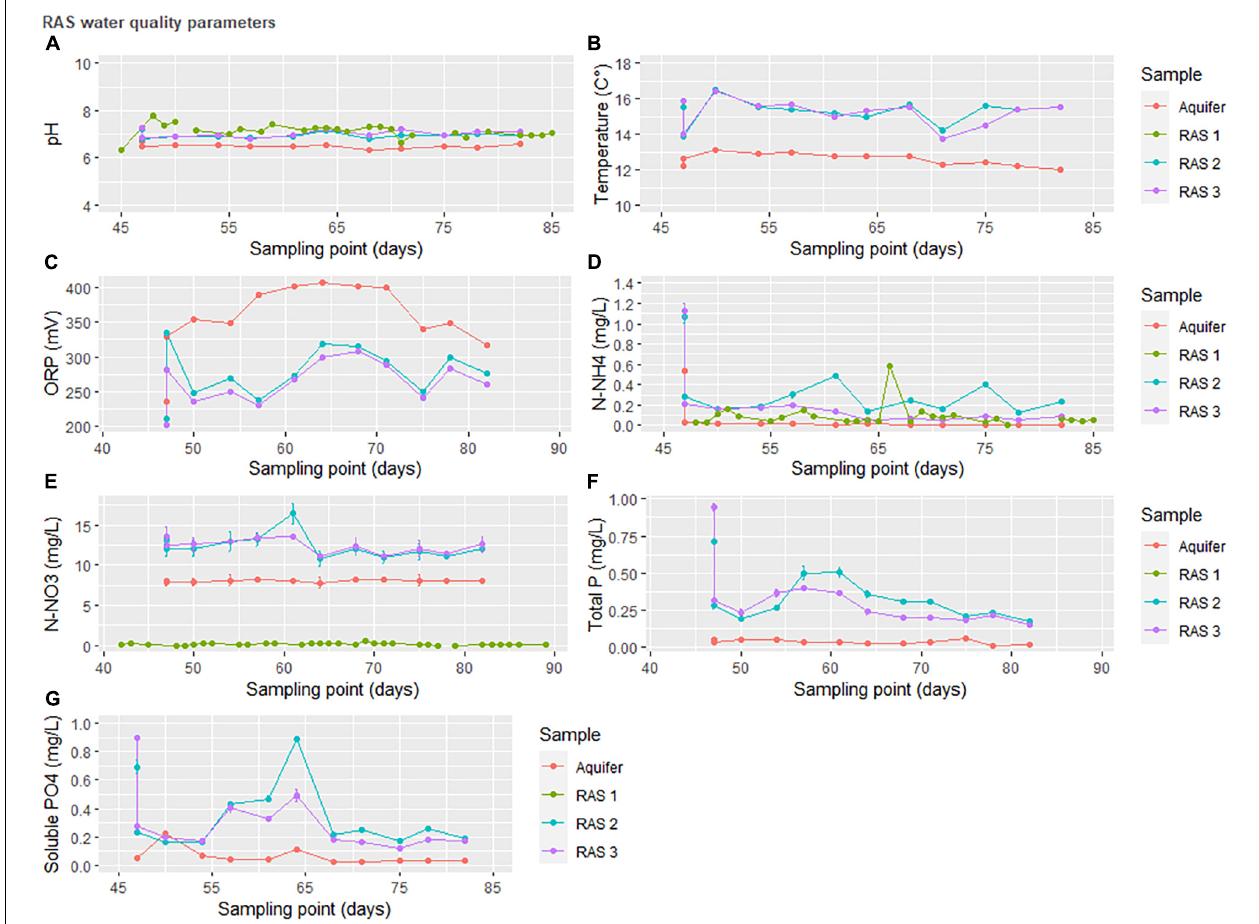
FIGURE 3 | Water quality parameters in the recirculating aquaculture system at INRAe-PEIMA between the coupling of the recirculating aquaculture system (RAS) to the greenhouse (day 45) and the end of the experiment (day 81). RAS1 was operated as a traditional RAS, RAS2 ran as a traditional coupled aquaponics circulation system, and RAS3 contained both aqueous and solid waste treatment